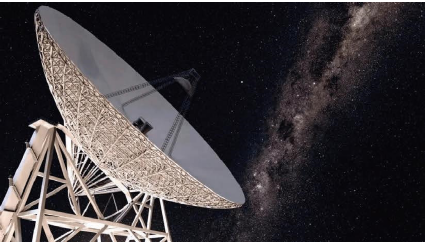
Figure 17: Design sketch of QTT (https://baijiahao.baidu.com/s? id � 1664409321011853698&wfr � spider&for � pc).